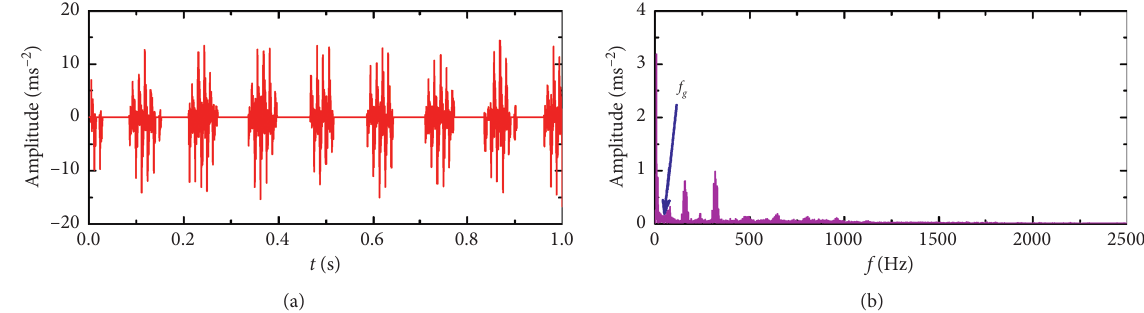
Figure 8: The simulated results using the SBAKW: (a) extracted signal and (b) Hilbert envelope spectrum of signal in (a).